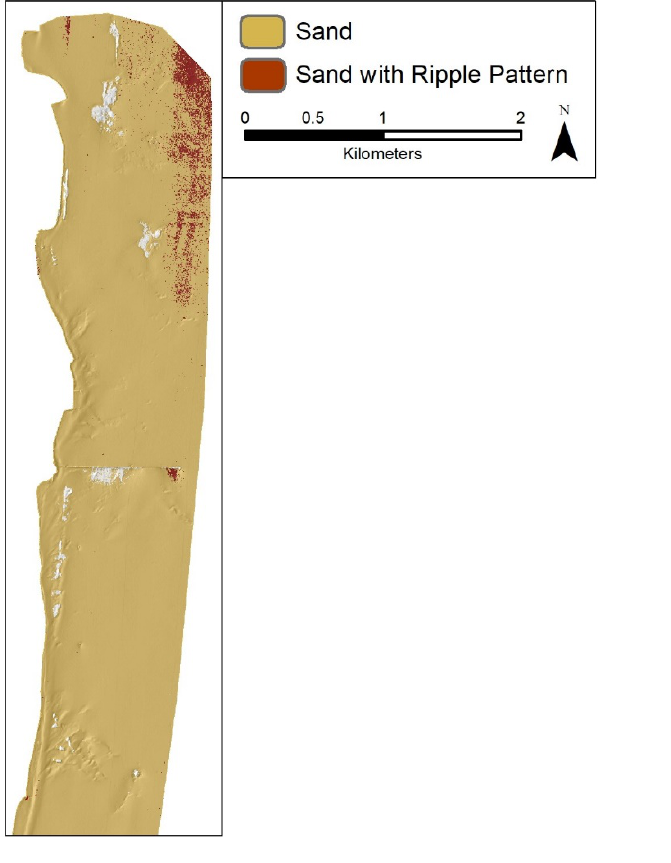
Figure 15. Tier 2 fine unconsolidated (substrate) classification results using airborne data combina- tions for the north-central section of the study area: CA MNF WLR + CA MNF FU + AB DE and CA MNF FU + CA MNF WLR.